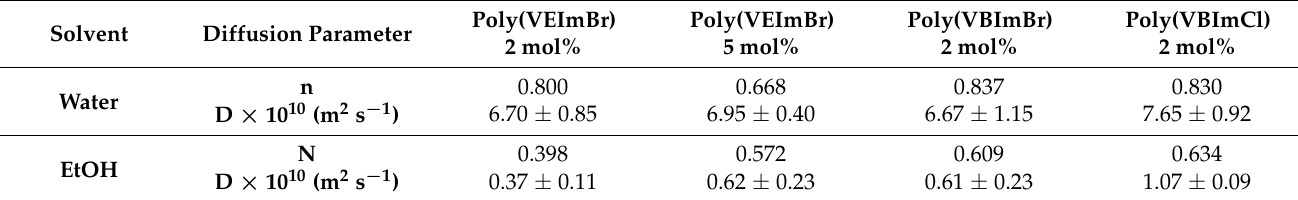
Table 4. Diffusional exponent n and diffusion coefficient D determined by gravimetric swelling studies at 30 ◦ C. Solvent Diffusion